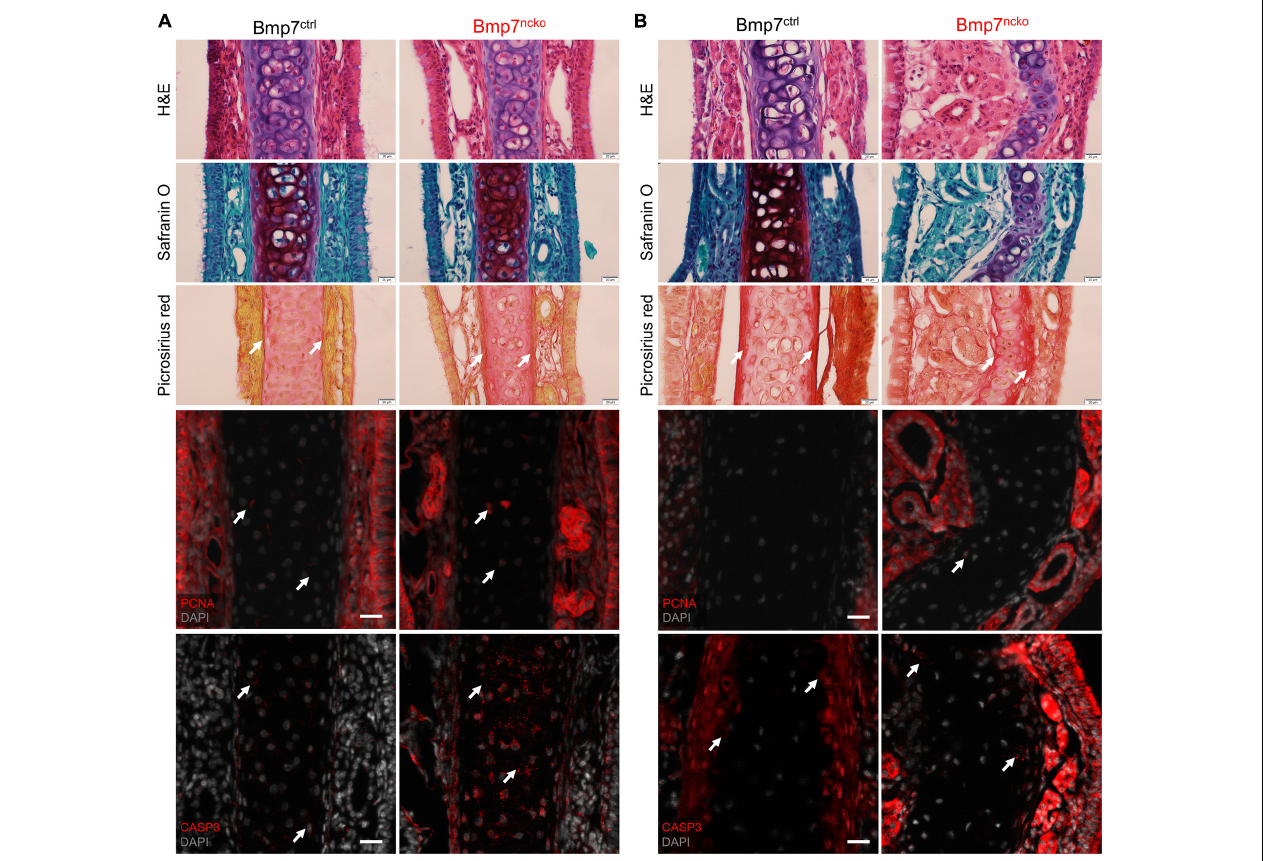
FIGURE 2 | Cell death altered glycosaminoglycan and collagen fibril organization observed in Bmp7 ncko mice. Histological staining on nasal septum paraffin sections at P14 (A) and P30 (B) timepoints ( n = 3/genotype/age). Hematoxylin (purple) and Eosin (pink) (H&E) staining for gross morphology of the nasal septum. Representative Safranin O (red) staining for cartilage and Picrosirius Red (pinkish-red) staining for collagen fibers. Reduction in Safranin O staining was observed only in P30 Bmp7 ncko mice. To identify proliferation in the nasal septum, immunofluorescence staining using PCNA antibody (red) was performed with sections counterstained with DAPI for nuclei (gray). No changes to proliferation were observed. Apoptosis was characterized using CASP3 antibody (red) and counterstained with DAPI for nuclei (gray). Apoptosis precedes nasal septum deviation in Bmp7 ncko mice. PCNA, proliferating cell nuclear antigen; CASP3, cleaved caspase 3. Arrows denoting positive stain/signal. Scale bar (histological stains) = 20 µ m and (Immunos) = 50 µ